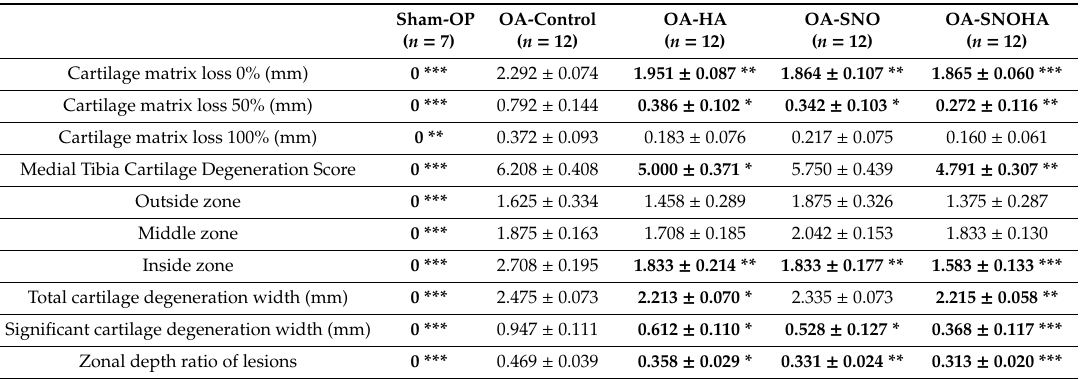
Table 1. Histological scoring of OA knee joint.